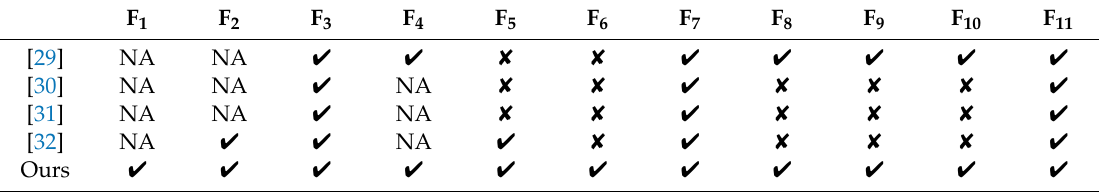
Table 5. Feature-based characterization of our proposed protocol in comparison with other